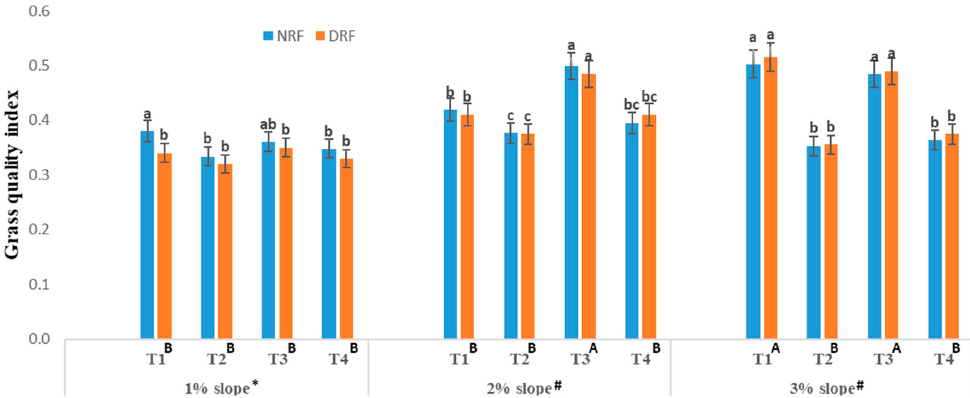
Figure 6. Grass quality index across variable slopes (1–3%) in two different rainfall situations. A and B both differ significantly at the 1% level of significance between the treatments irrespective of the slopes. abc all differ significantly at the 5% level of significance between the treatments within a particular slope level in different rainfall situations. * # both differ significantly at the 5% level of significance between the slopes. T1, the top and bottom Stylosanthes strip; T2, only the bottom strip of Stylosanthes ; T3, the top and bottom Brachiaria strip; and T4, only the bottom strip of Brachiaria .